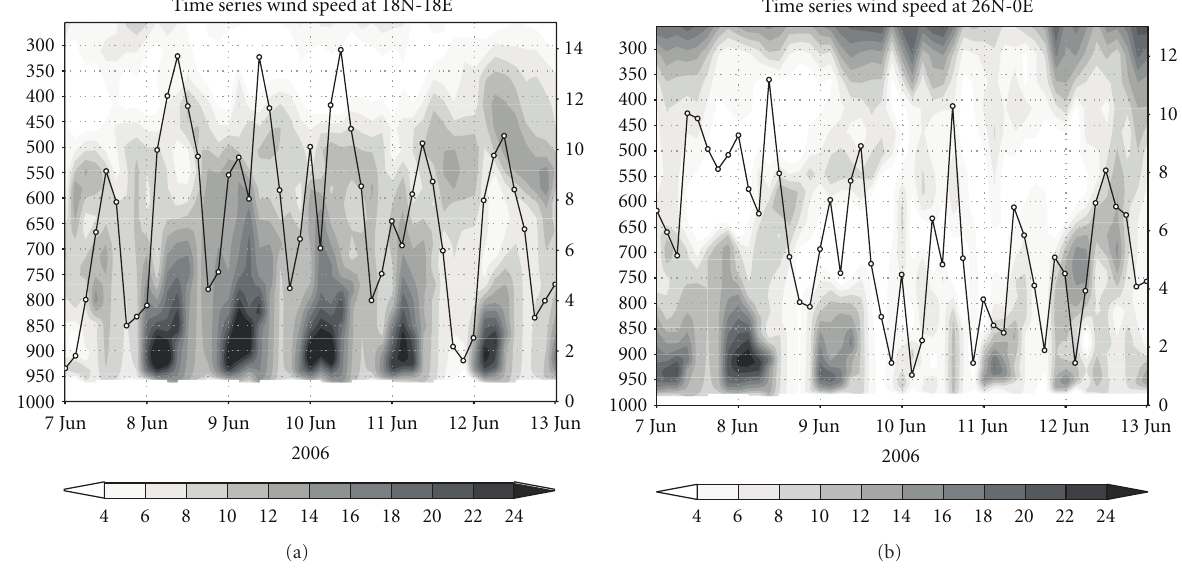
Figure 8: Time series of WRF-Chem EXP30-simulated wind speeds at the surface (10 m height, line) and in the lower atmosphere (shaded) over the (a) Bod´el´e Depression (18 ◦ N,18 ◦ E) and (b) central Algeria (26 ◦ N, 0 ◦ E). These locations are roughly coincident with sources of dust features B1–B4 and A1-A2, respectively, in Figure